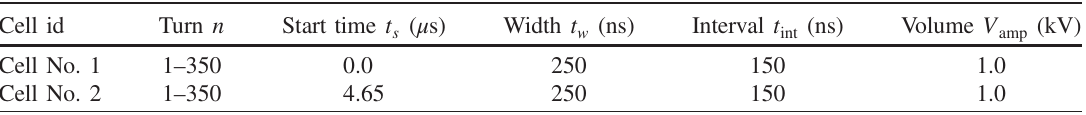
TABLE I. Trigger timings and amplitudes of the acceleration pulse in the SBB.